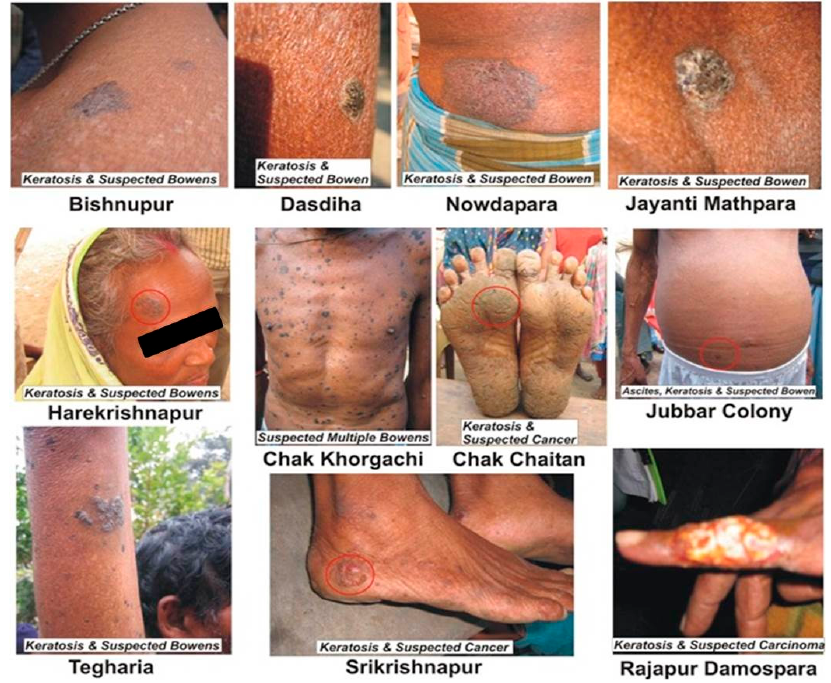
Figure 3. Patients suffering from arsenical keratosis, affected by pre-malignancy.